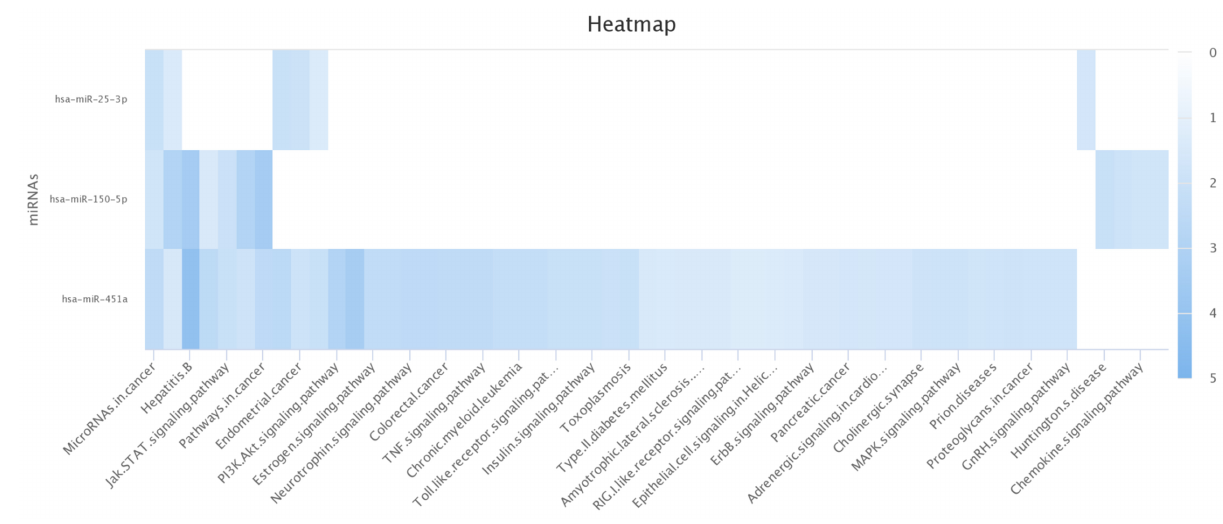
after “Moro” orange juice ingestion, compared with placebo and “Pera” orange juice ingestion. However, there was no change in lipid hydroperoxide